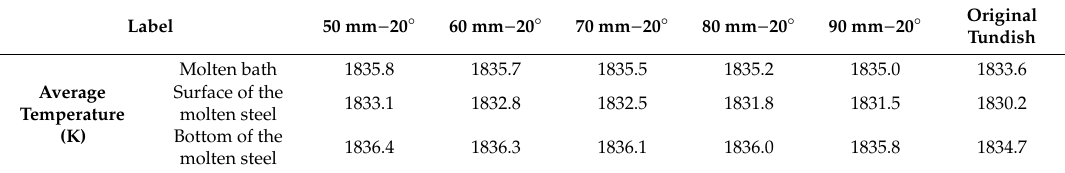
Table 3. The average temperature distribution for the molten steel.